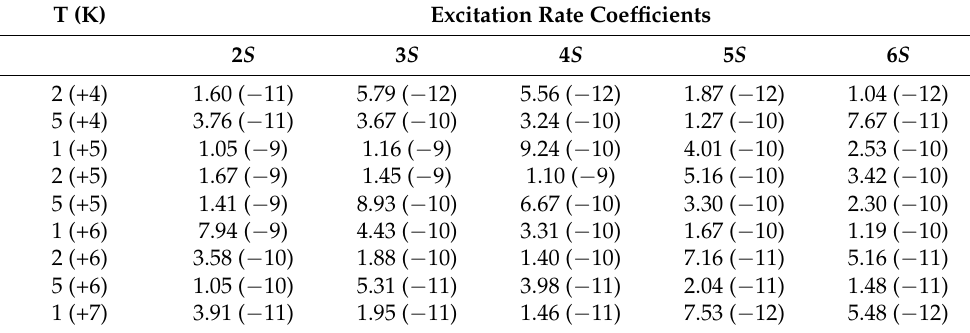
Table 4. Excitation rate coefficients for nS states, n = 2 to 6, at various temperatures. T